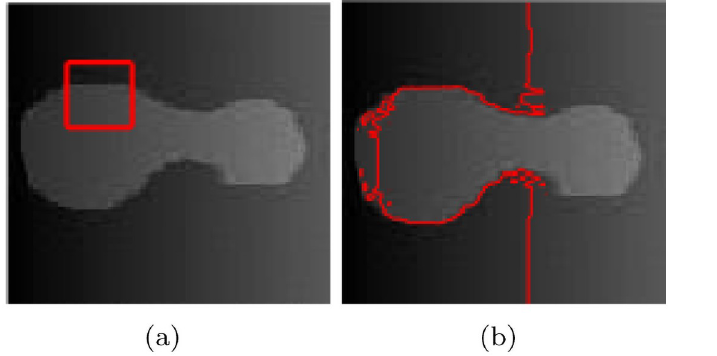
Fig 2. The segmentation result of uneven intensity image using (14).